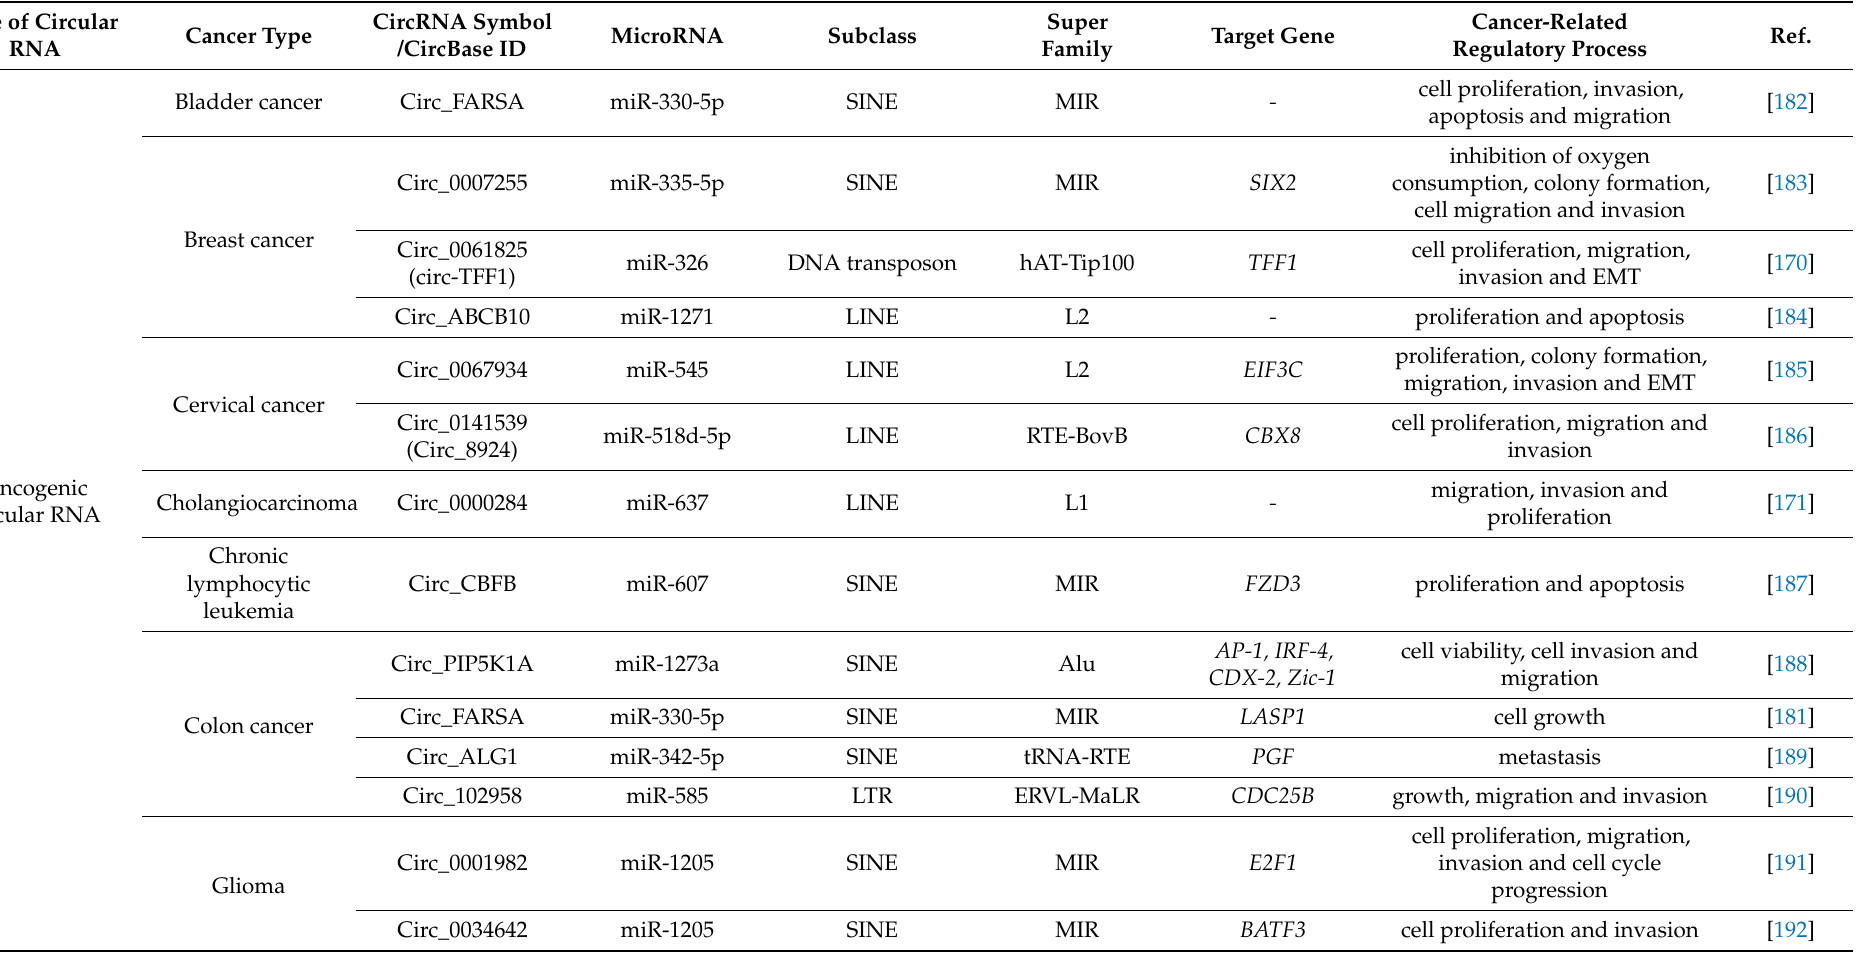
Table 2. List of miRNAs derived from transposable element (MDTEs) regulated by oncogenic and tumor-suppressive circular RNAs and its dysregulated target genes in various cancer